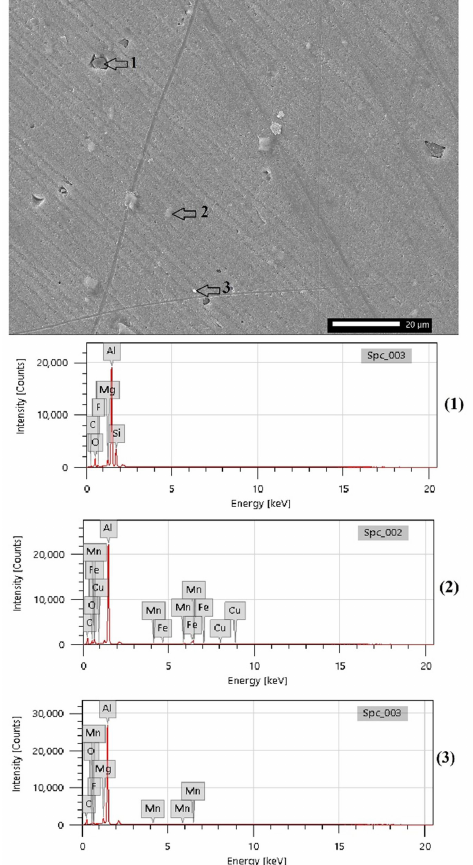
Figure 5. SEM-EDS precipitates of the aluminum alloy AA 5182heated to 250 °C for 10